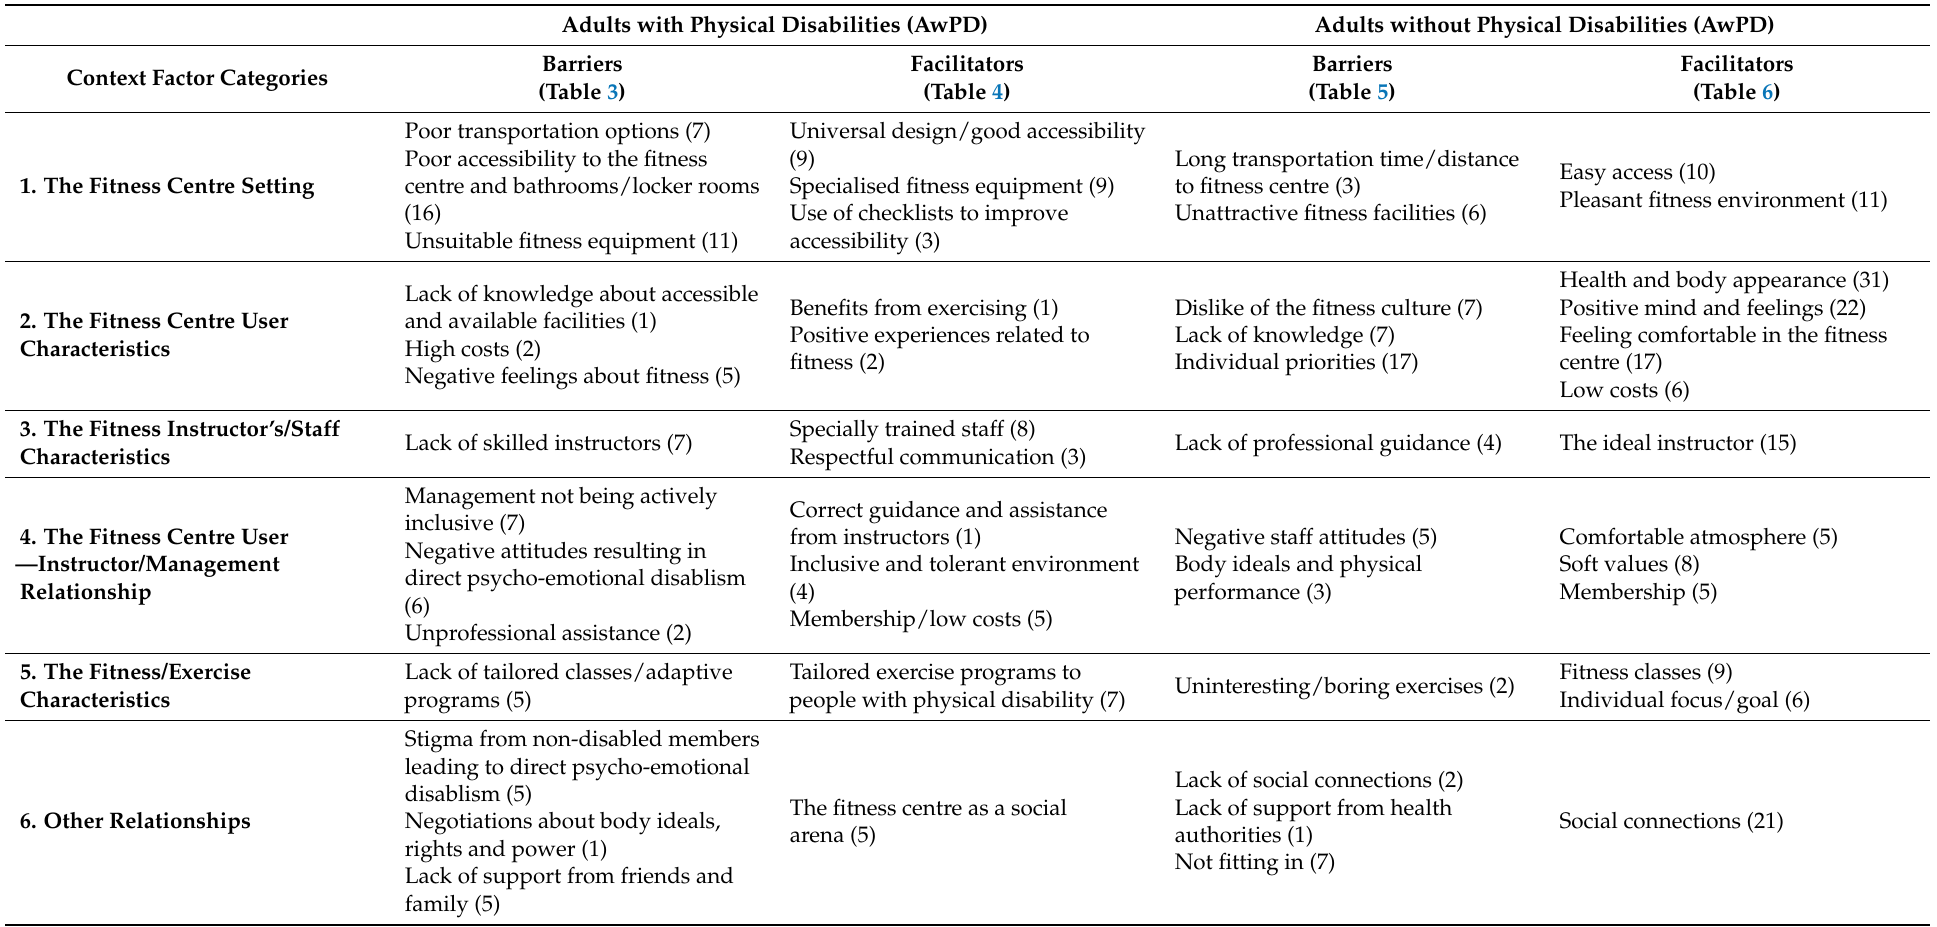
Table 7. Overview of the barriers and facilitators for the two groups (Tables 3–6), related to the six context factor categories. Numbers in parentheses refer to the total number of different papers informing each of the